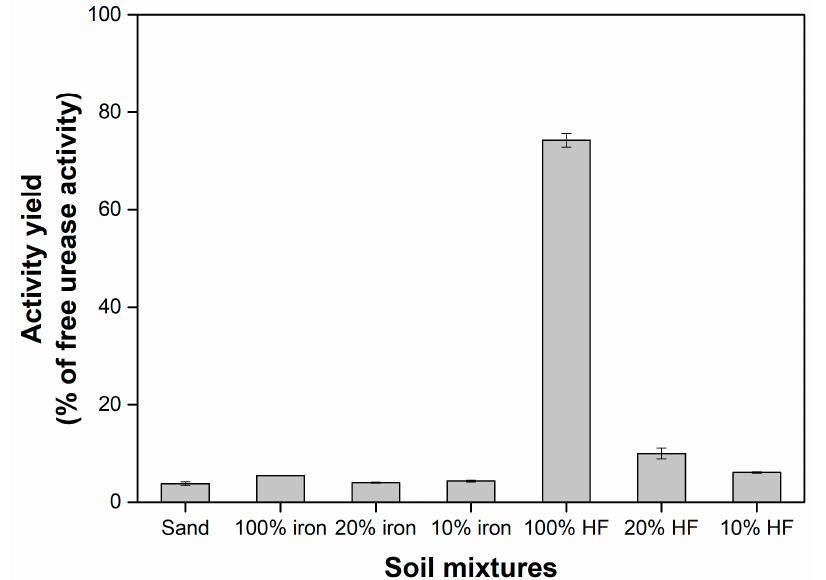
Figure 4. Urease activity yield upon adsorption. Activity yield was calculated as the % of activity of adsorbed urease in each soil mixture normalized to the activity urease in the initial total protein extract. Data shown represent the average of three independent experiments, with error bars indicating one standard error.